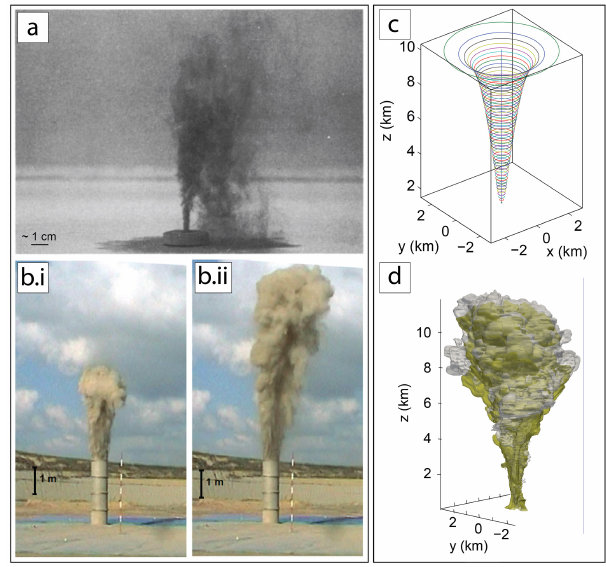
Figure 14. Examples of numerical simulations and analogue mod- els of volcanic plumes. (a) Flume tank analogue experiments of Carey et al. (1988) in which a particle-laden fluid is injected into another fluid to investigate plume rise and particle sedimentation dynamics. (b) Large-scale experiments to investigate effects of en- trainment coefficient on plume rise (Dellino et al., 2014). (c) Mod- elled representation of a vertical plume using the one-dimensional model PLUME-MoM (de’ Michieli Vitturi et al., 2016). (d) Three- dimensional model results from the multiphase model ASHEE for the same input conditions as (c) (Cerminara et al.,